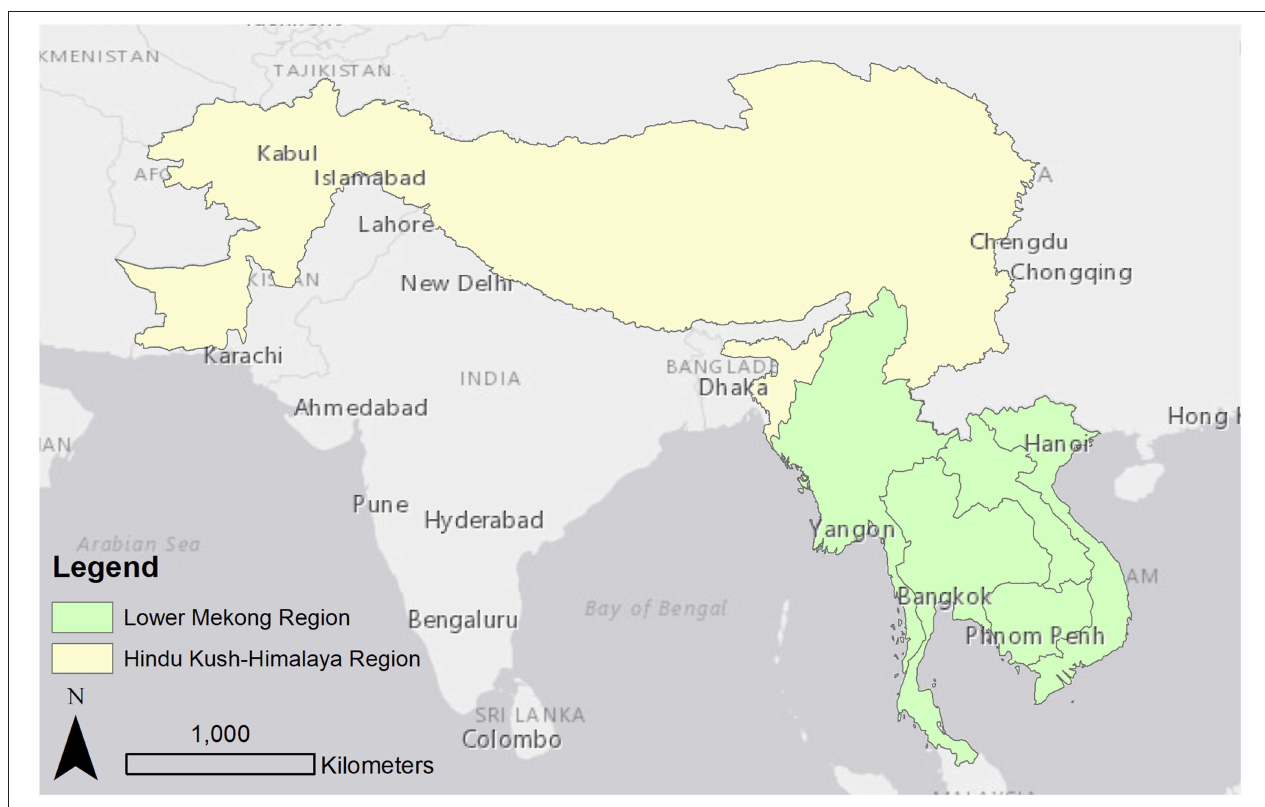
FIGURE 1 | Study area map highlighting South-Southeast Asia with the Hindu Kush-Himalaya (HKH) and the Lower Mekong region (LMR) and countries of focus.